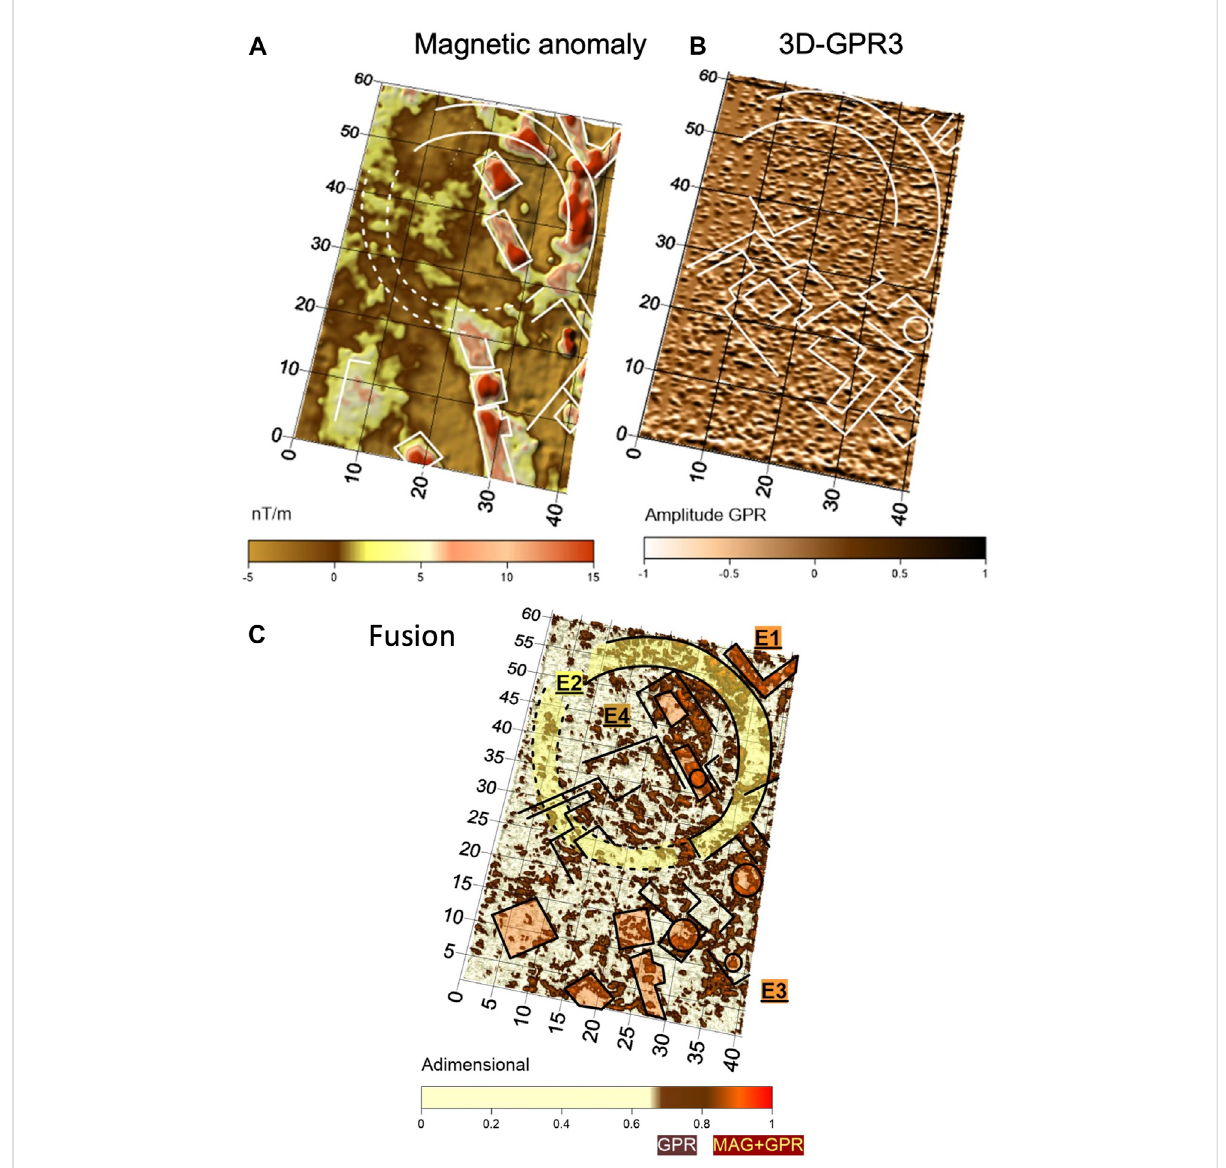
FIGURE 14 Visualization of the models obtained in sector A1. (A) Magnetic anomalies. (B) 3D-GPR3 dataset. (C) Fused data. We drew the most signi fi cant interpretive lines on the three models. The fused dataset has more information available than the inputs